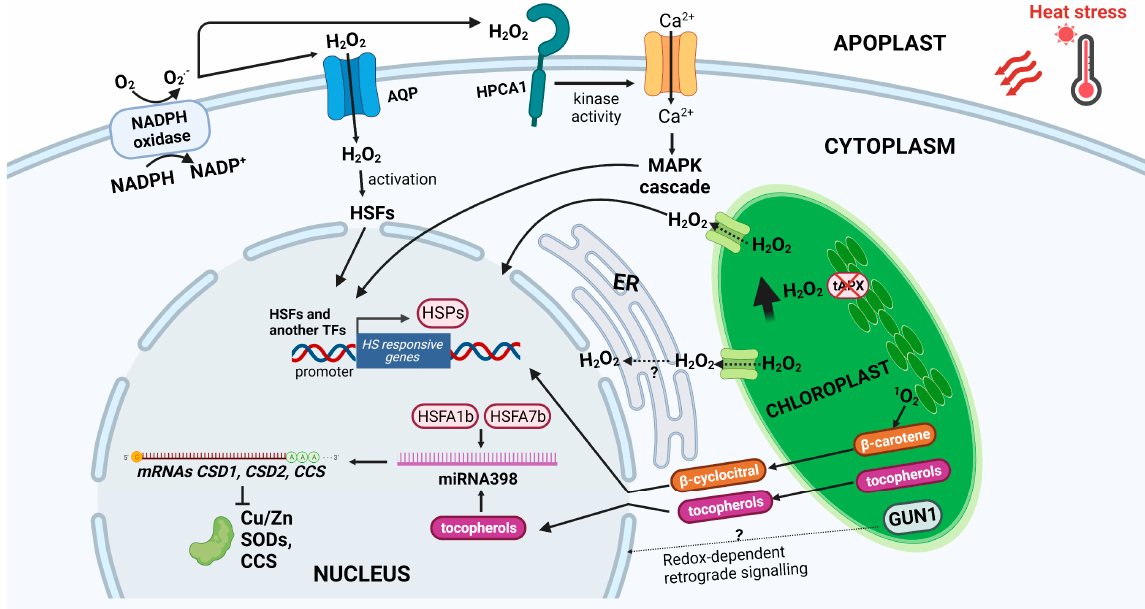
Figure 1. Mechanisms of ROS accumulation and signaling in heat stress response. After heat stress, production, and accumulation of reactive oxygen species (ROS) occurs in both chloroplasts and apoplast. 1 O 2 accumulation in the chloroplast, oxidizing β -carotene, produces β -cyclocitral, which acts as a retrograde signal from chloroplast to nucleus, activating heat stress-responsive (HSR) genes. In chloroplasts, damage to photosynthetic apparatus, as well as inhibition of tAPX, lead to accumulation of H 2 O 2 , which moves to the nucleus through aquaporins, and/or ER, thus inducing HSR genes. The chloroplast-localized GUN1, by the redox-dependent plastid to nucleus communication, is involved in cell environment oxidation. ROS increase is also due to downregulation of CSD1 , CSD2 , and